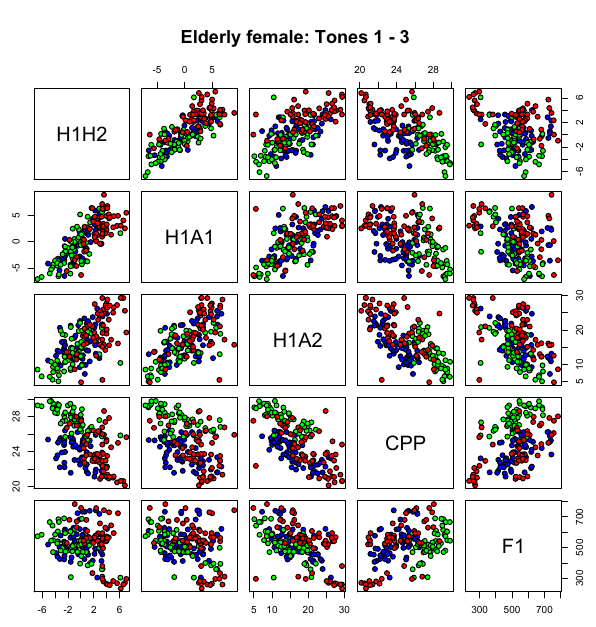
Figure 6 : Scatterplot matrices with five acoustic measures of breathiness for elderly females: blue for T1, green for T2, and red for T3.